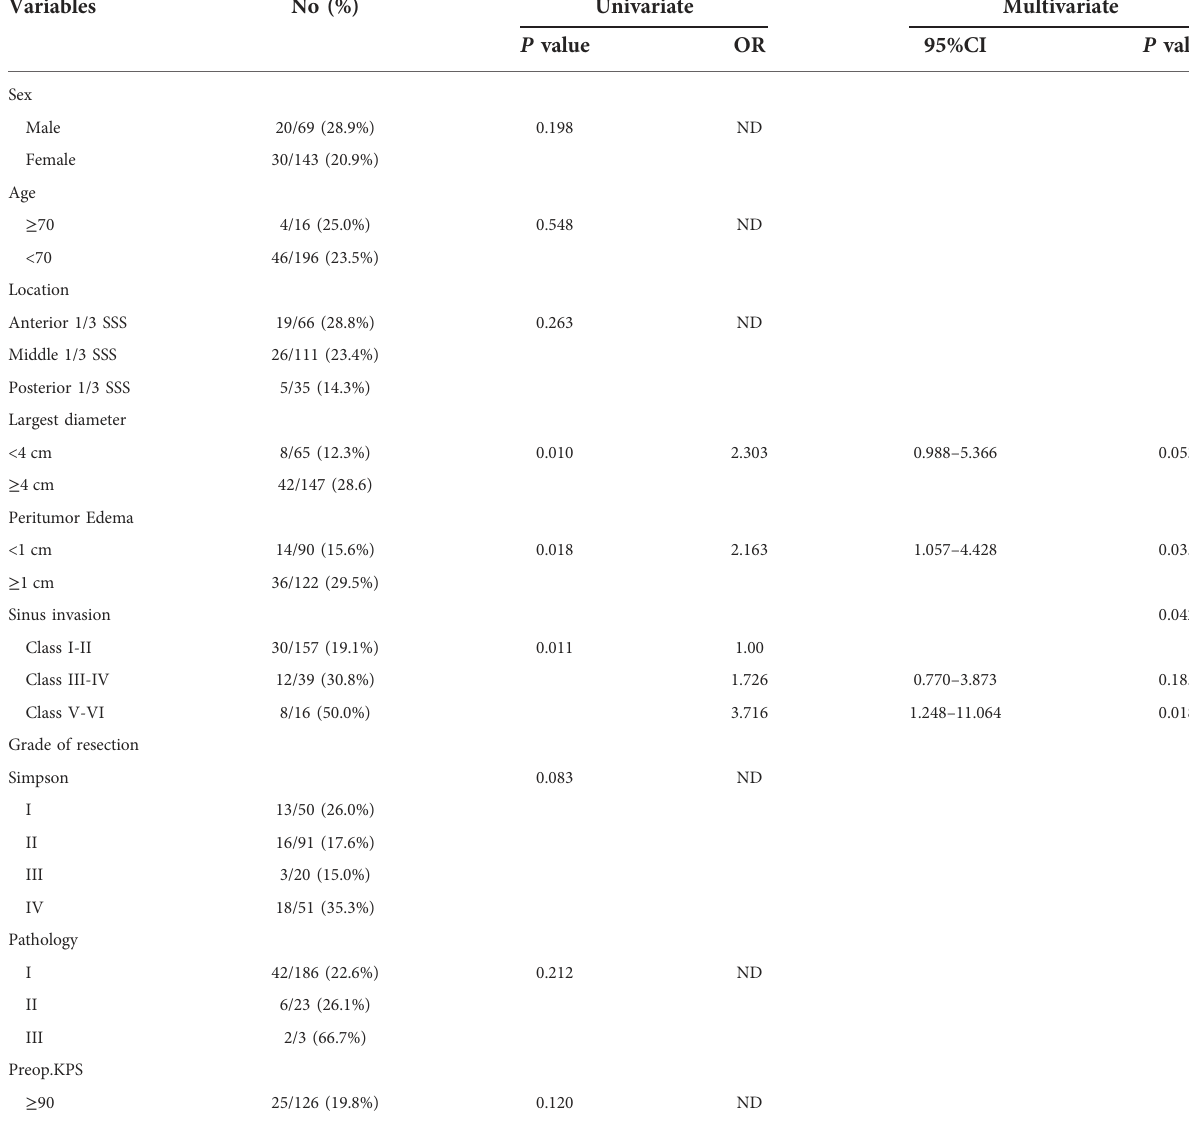
TABLE 3 Predictive factors of 212 patients with parasagittal meningiomas who had complications based on univariate and multivariate analysis.